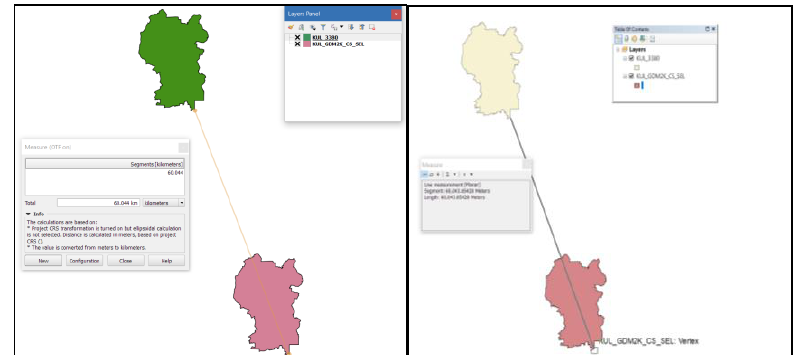
Figure 3: Vertical Spatial Displacement of ESPG:3380 and User Defined Geocentric Cassini Selangor / FT Kuala Lumpur Map Projection Using QGIS Version 2.18.15 (Left) and ArcGIS 10.3